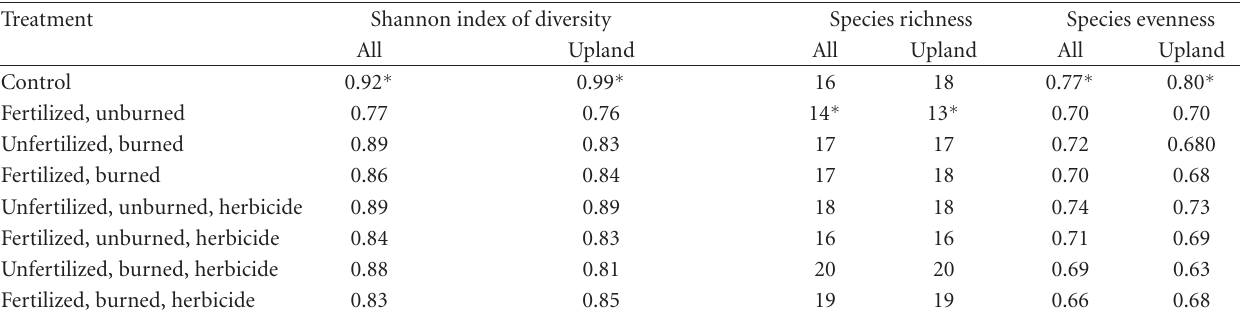
Table 3: Alpha diversity measures combined for all replicates and only the upland replicates (riparian replicates eliminated at cherokee ridge site), cherokee ridge and sweet union research sites combined, east Texas, USA. ∗ significantly di ff erent at P = .1 from other treatments within column from analysis of various test proc GLM (SAS, ver 8).